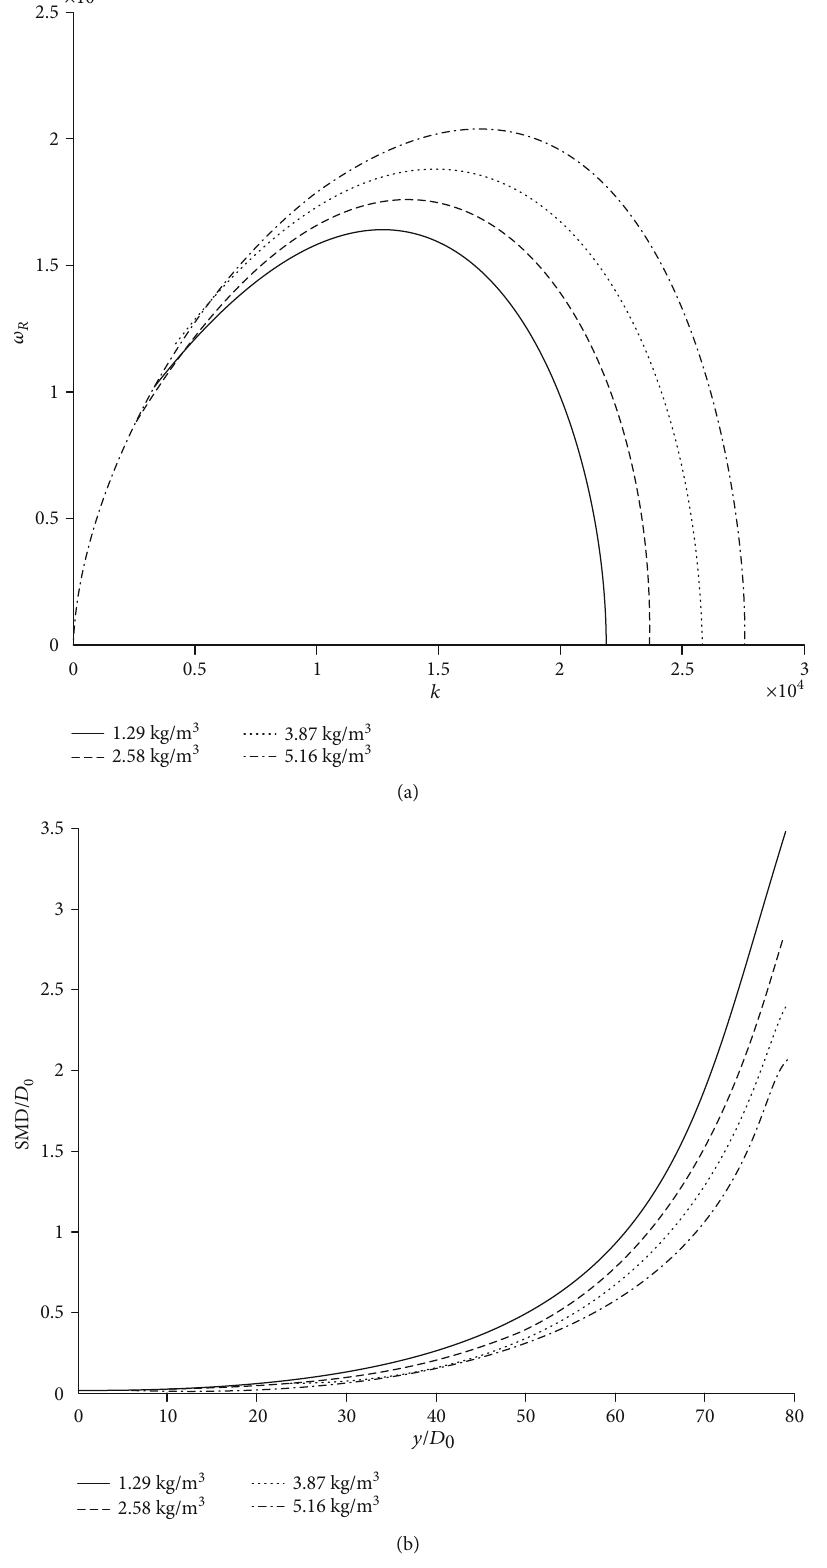
Figure 7: E ff ect of transverse gaseous density to (a) surface wave growth rate and (b) droplet size distribution ( σ = 0 : 0728N/m 2 , ρ = 13 : 39 m/s , and q = 96 : 35 1000kg/m 3 , u L